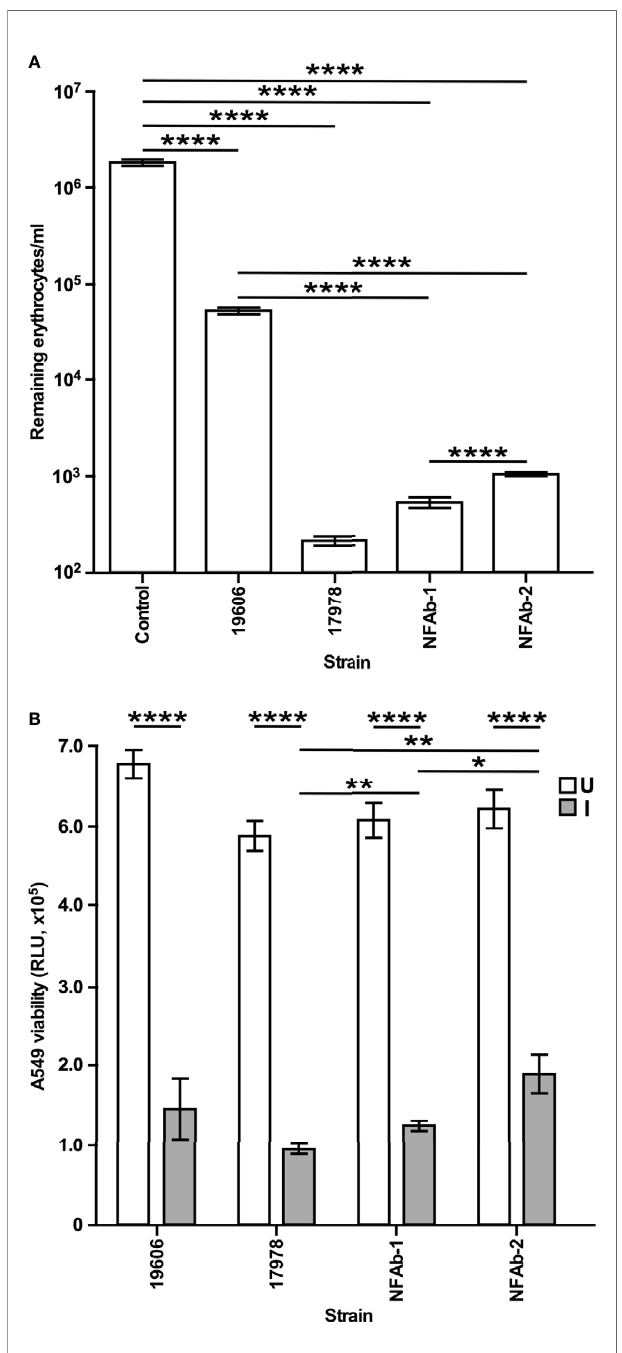
FIGURE 5 | A . baumannii effect on host cell viability. (A) Hemolytic activity was tested by determining the number of horse erythrocytes remaining after incubation with cells of each of the A. baumannii strains at 37°C with shaking. (B) The effects of A. baumannii strains on A549 cell viability uninfected (U) or infected (I) with bacteria for 20 h at 37 °C with 5% CO2 was quanti fi ed using the CellTiter-Glo luminescent cell viability assay. The results, which are expressed as relative luminescence units (RLU), represent triplicates of three independent biological samples. Horizontal bars identify statistically different values ( P ≤ 0.05, *; P ≤ 0.01, **; P ≤ 0.0001,****) and error bars represent the standard error of each data